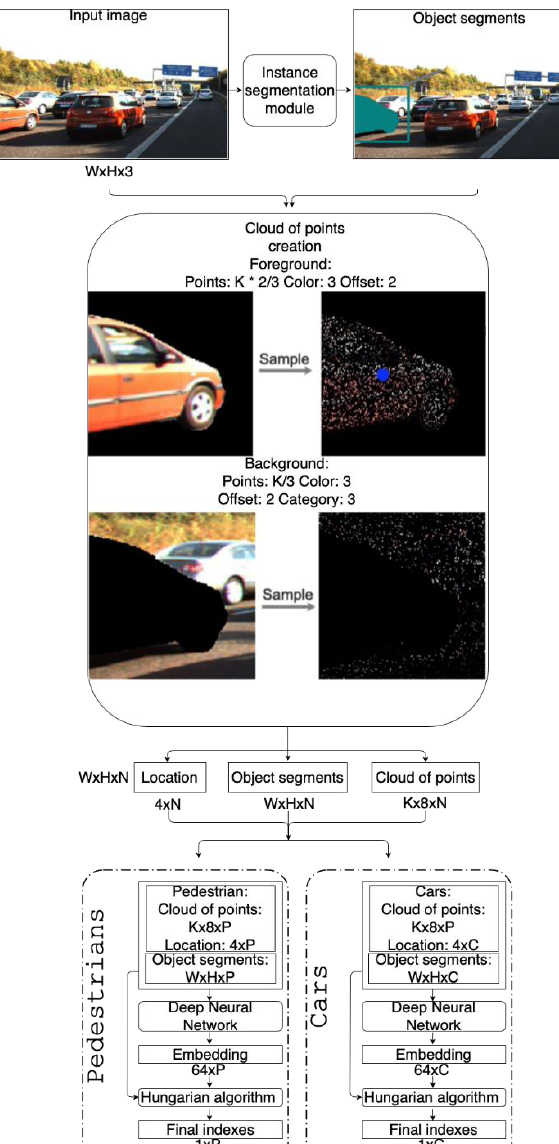
Figure 1. Proposed multi-object tracking and segmentation approach.